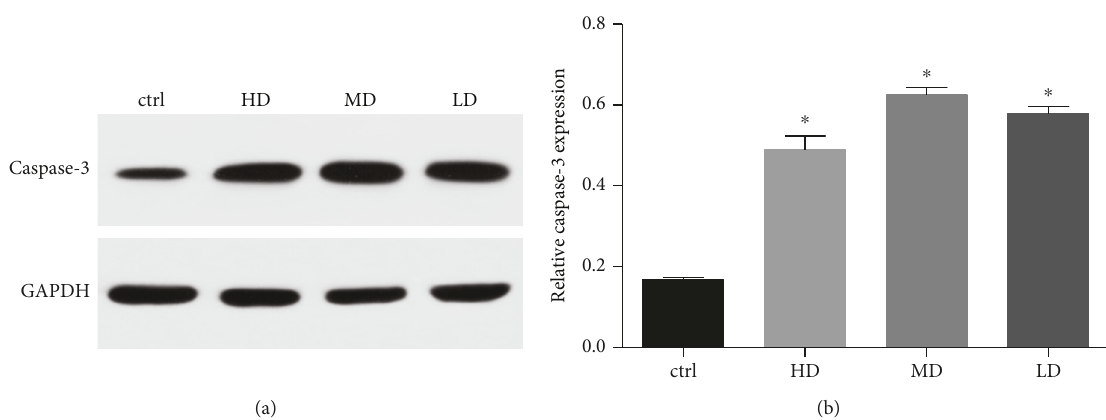
Figure 4: Western blot assay for caspase-3 protein levels of prostate cancer. (a, b) The e ff ect of di ff erent doses of nanoyam polysaccharide on expressions of caspase-3 in mice tumor tissues. All experiments were triplicated. Data were presented as mean ± SD . ∗ p < 0 05 , compared with the control